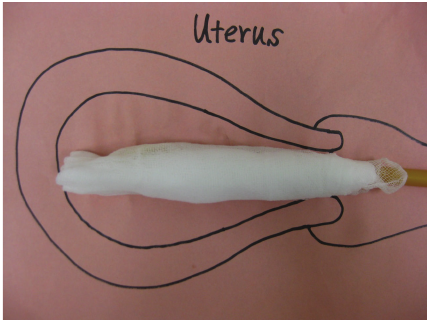
Figure 3: The catheter with the rolled gauze is inserted gently into the uterine cavity using ring forceps. A lubricating jelly may be applied on the tip of the catheter, if needed.